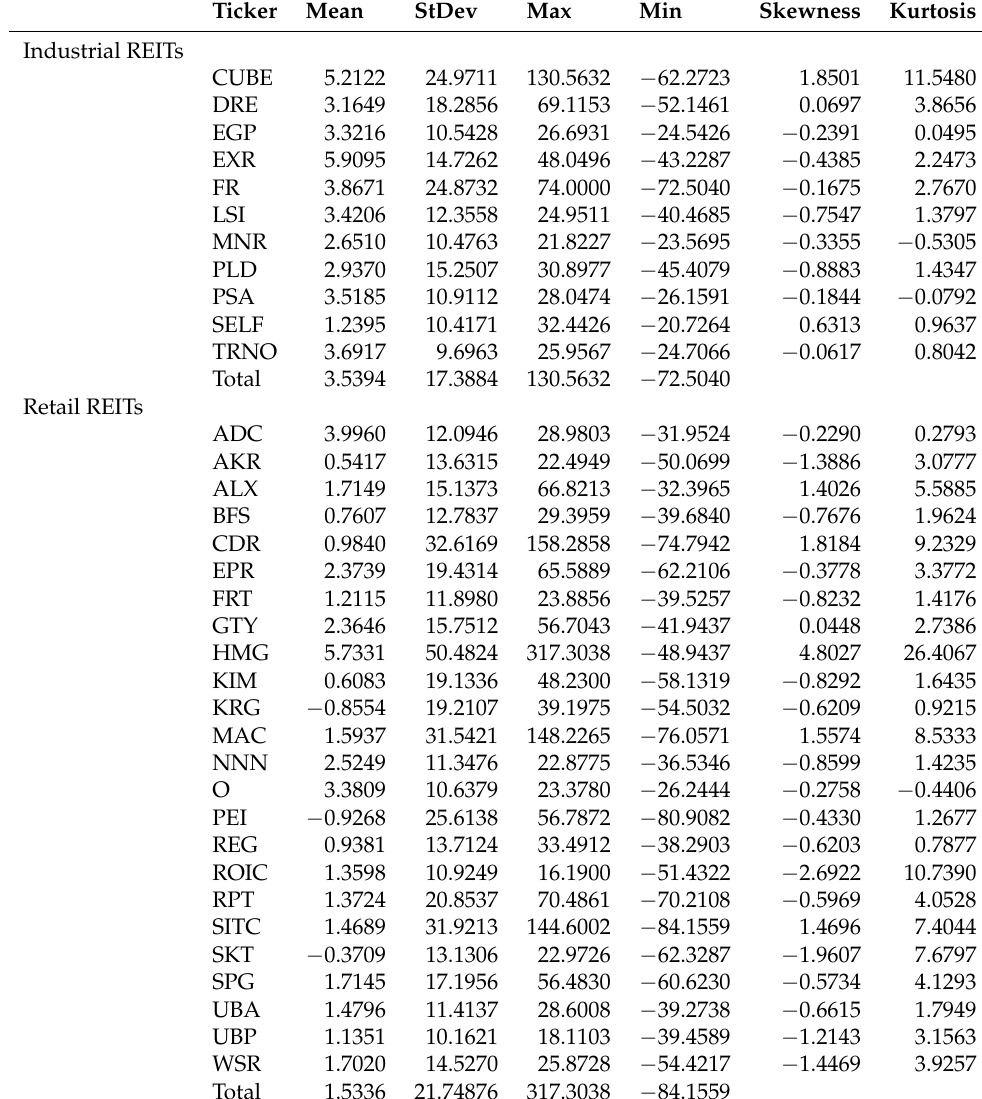
Table A2. Descriptive Statistics for Industrial and Retail REITs Quarterly Returns, Whole